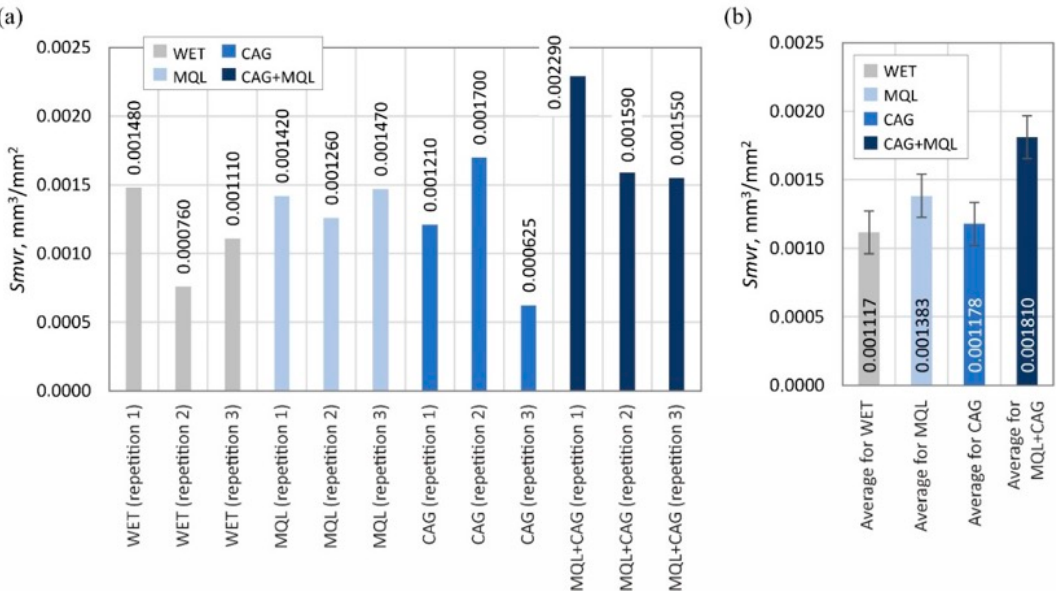
Figure 9. Chart of changes in the mean void volume ratio Smvr : ( a ) results for the twelve blades selected for the surface texture measurements; ( b ) mean values of the parameters divided by cooling and lubrication methods of the grinding zone used during the shaping of the blades (error bars represent the standard error equal to the standard deviation σ divided by the square root of the total number of